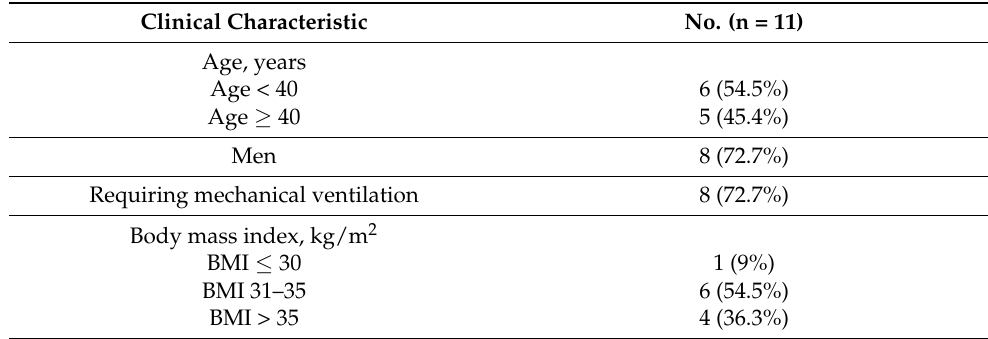
Table 1. Clinical characteristics of patients with COVID-19 of Cohort #1 (soluble VCAM-1) No. = number, BMI = Body mass index.